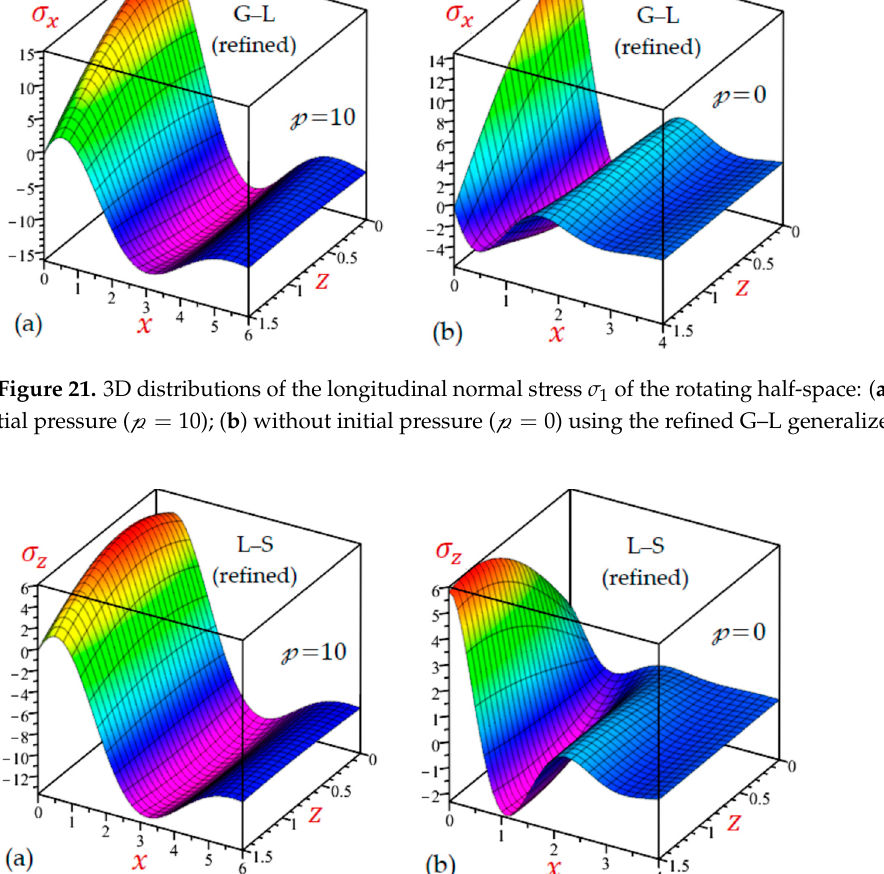
Figure 22. 3D distributions of the transverse normal stress 𝜎 (cid:3053) of the rotating half-space: ( a ) with